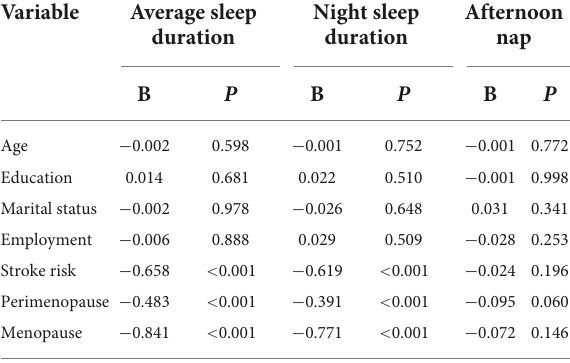
TABLE 3 General linear regression on the relationships between menopause and sleep duration. Variable